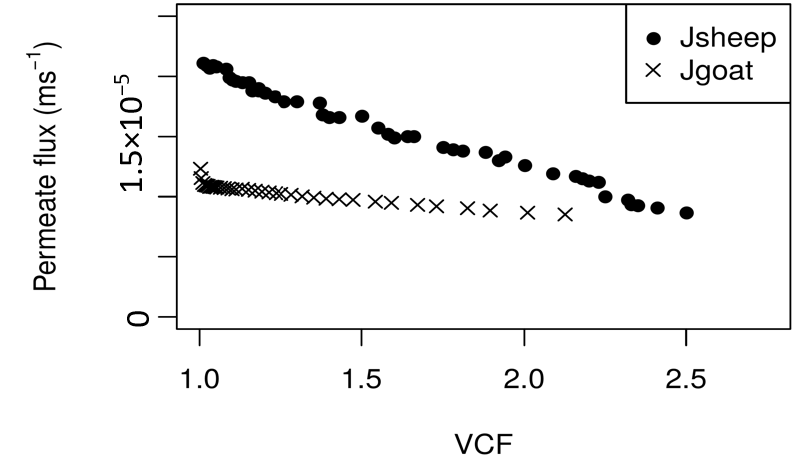
Figure 4. Variation of average (3 replicates) permeate fluxes with the volume concentration factor (VCF) for the concentration by nanofiltration of PUF-S ( ∆ P = 3.0 × 10 6 Pa; <v> = 1.42 m · s − 1 ) and PUF-G ( ∆ P = 2.0 × 10 6 Pa; <v> = 0.94 m · s − 1 ), at T = 25 °C.